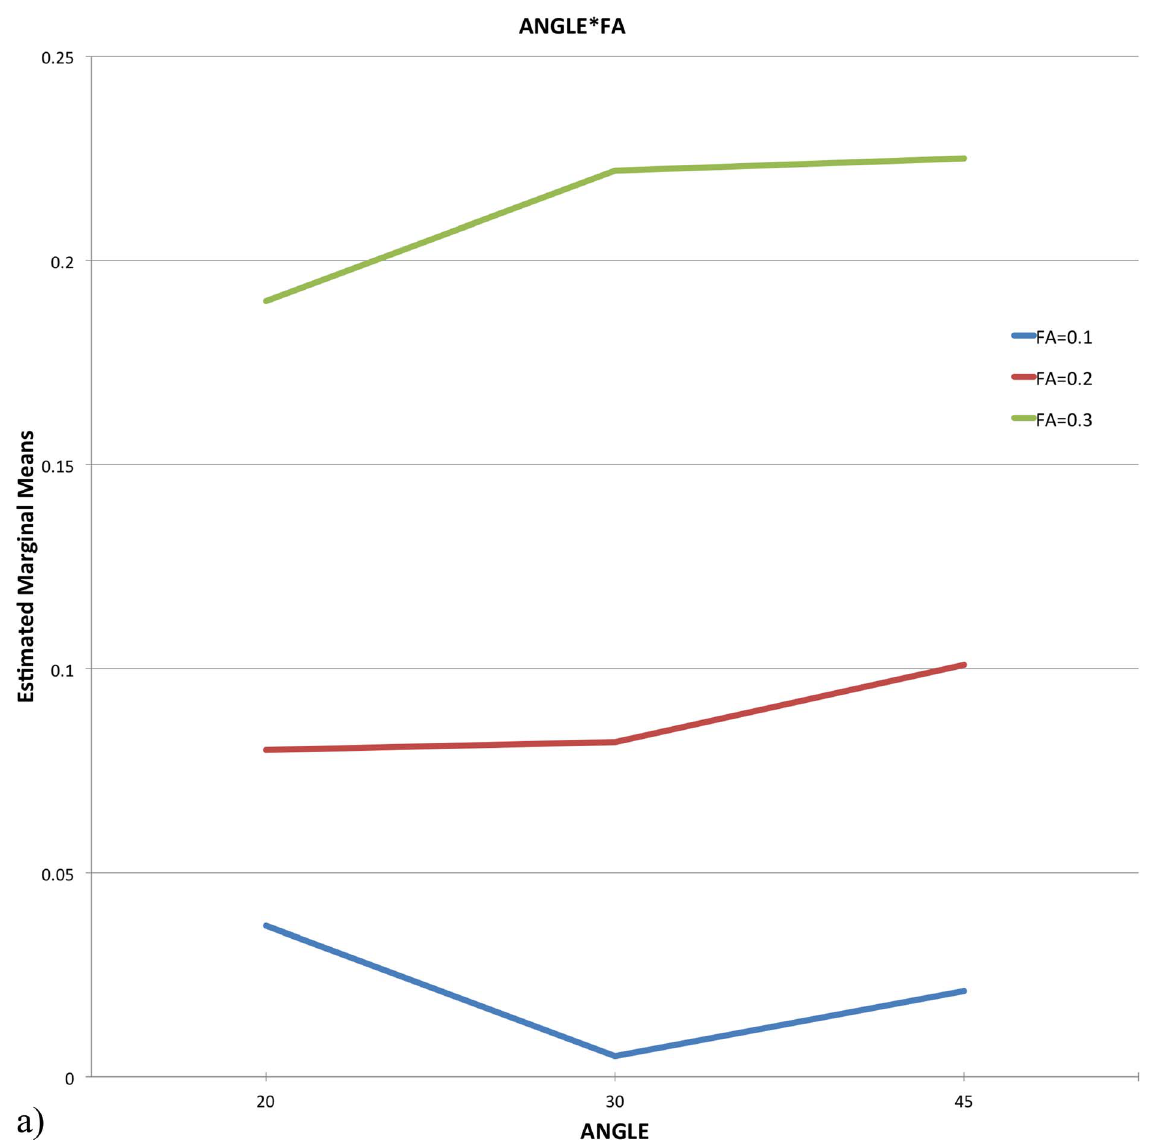
Figure 1. Repeated-measures ANOVA: Interaction graphs for ANGLE*FA. The graph illustrates that the FA threshold is essential for modulating the lateralization effect.